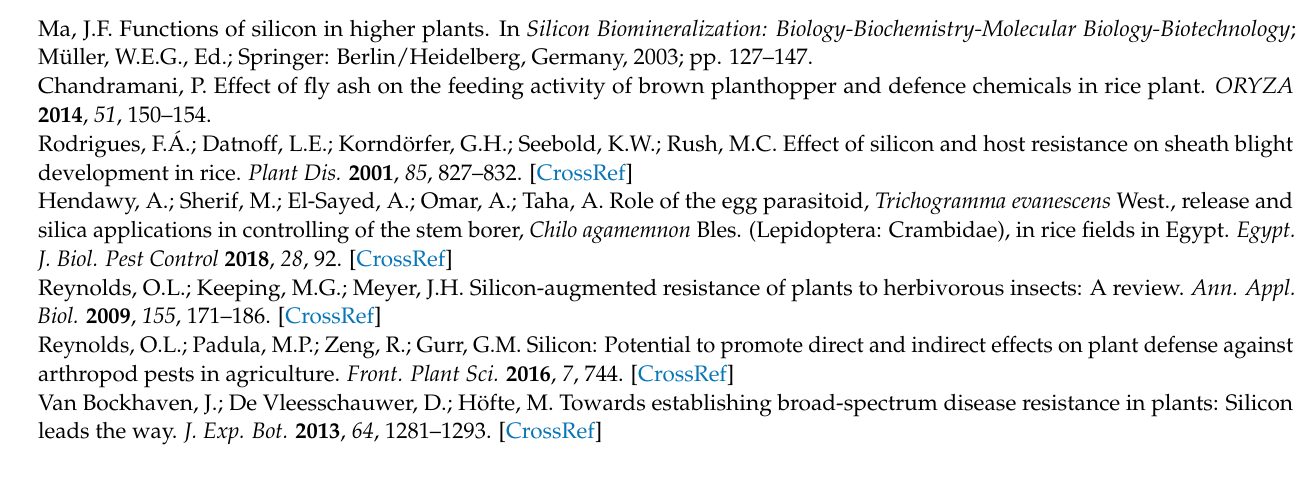
Table S4: Results from choice and no-choice experiments conducted with GLH in the Philippines; Table S5: Results from choice experiments conducted with BPH in the Philippines: Table S6: Results from choice experiments conducted with WBPH in the Philippines; Table S7: Results from no-choice experiments conducted with BPH in Vietnam; Table S8: Results from choice experiments conducted with BPH in Vietnam; Table S9: Results from experiments with blast disease conducted in the Philippines; Table S10: Results from experiments with bacterial blight disease conducted in the Philippines; Table S11: Results of repeated measures ANOVA for the bacterial blight